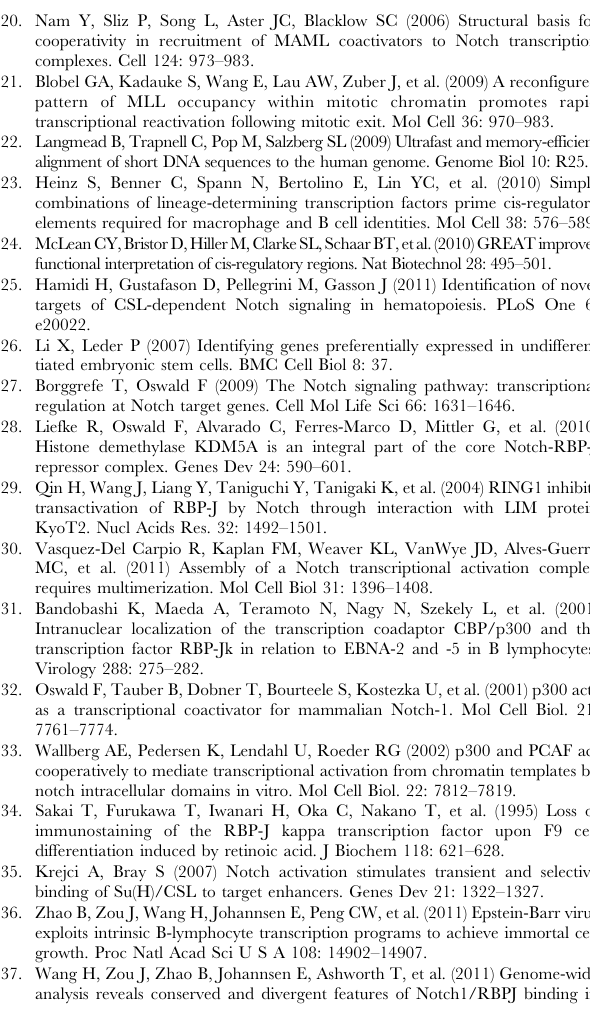
Table S1 GO analysis of RBPJ binding peaks common to asynchronous and mitotic F9 cells. Table S2 Annotation of RBPJ binding peaks in asynchronous F9 cells. Table S3 Annotation of RBPJ binding peaks in mitotic F9 cells. Table S4 GO analysis of RBPJ binding peaks in asynchronous binding motif. (C) RBPJ peaks containing the CTCF binding